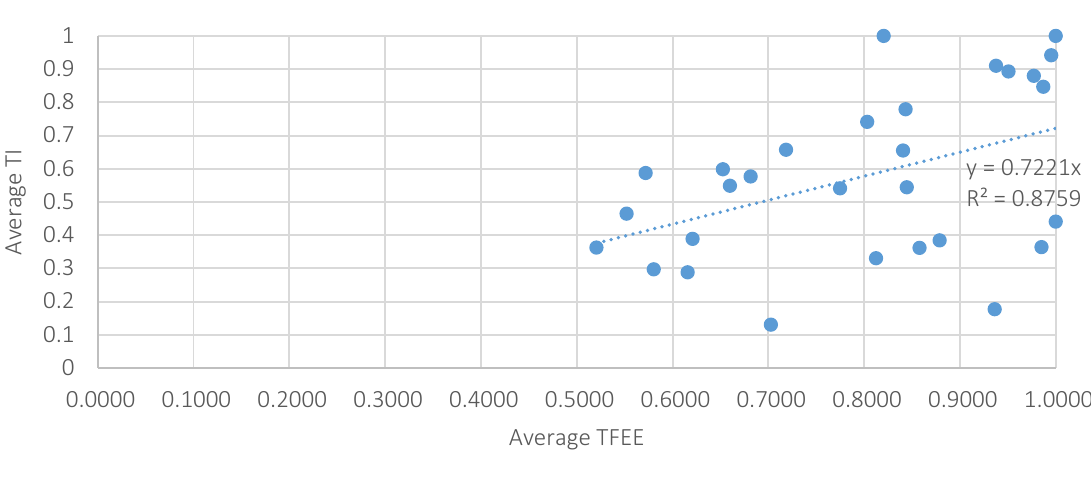
Figure 8. Correlation between TFEE and TI for 30 European economies, 2012–2020